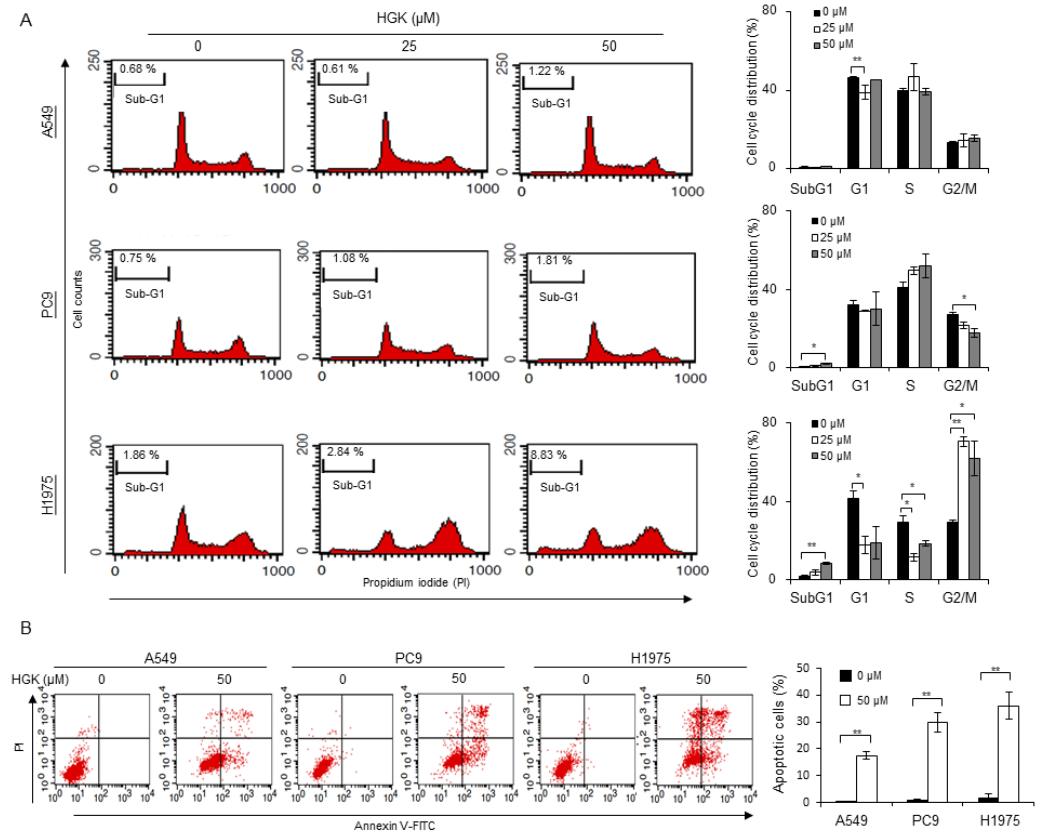
Figure 2. E ff ects of HGK on cell cycle and apoptosis in NSCLC cells. Cells were treated with HGK at the indicated concentrations for 24 h. ( A ) The distribution of cells in di ff erent phases of cell cycle was analyzed by flow cytometry of cells stained with propidium iodide. ( B ) Apoptosis was detected by flow cytometry of cells stained with Annexin V-FITC. The data shown are expressed as the mean ± SD of three independent experiments. Symbols: * p < 0.05 and ** p < 0.01, as analyzed by unpaired t